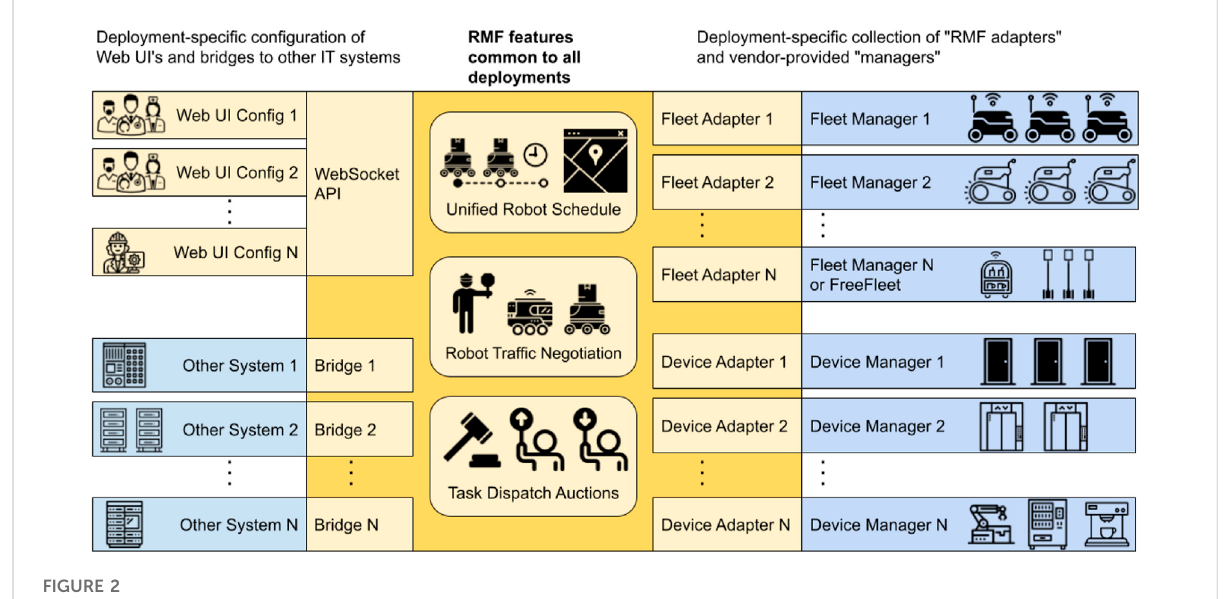
FIGURE 2 Run-time architecture of Robotics Middleware Framework Quigley